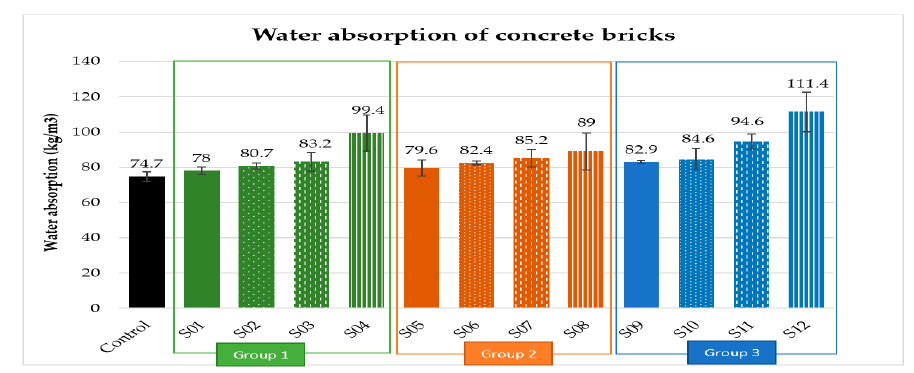
Figure 6. The water absorption of concrete bricks.